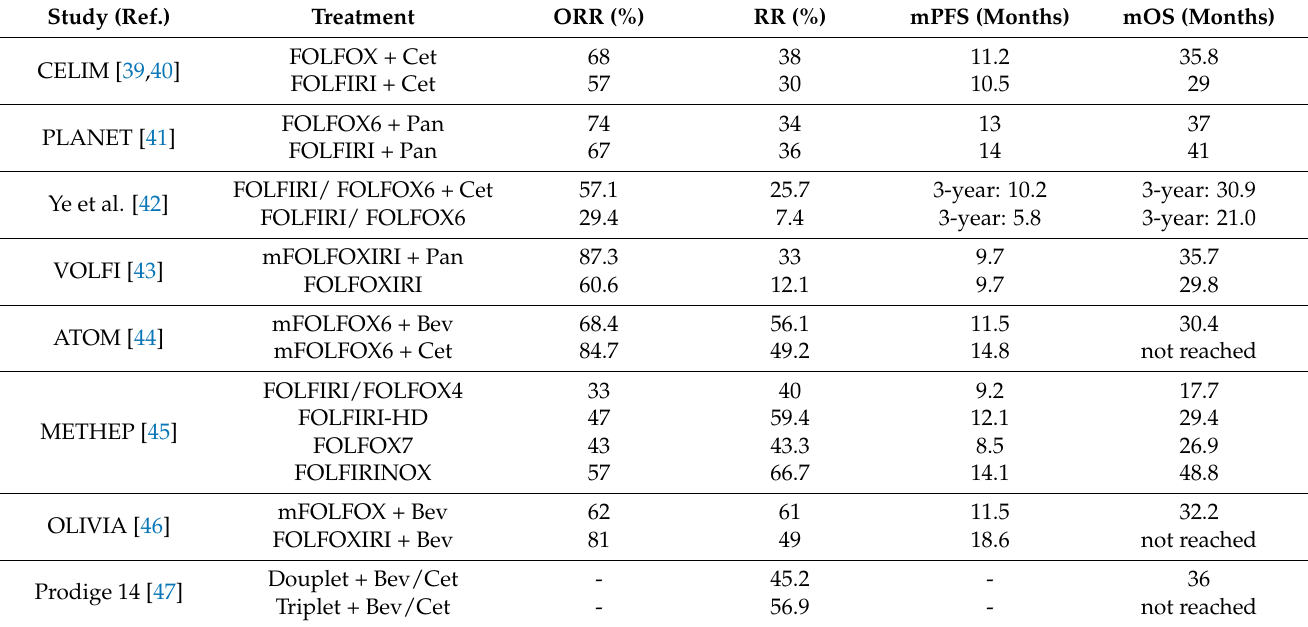
Table 1. Resection rates and outcomes of potentially or initially unresectable